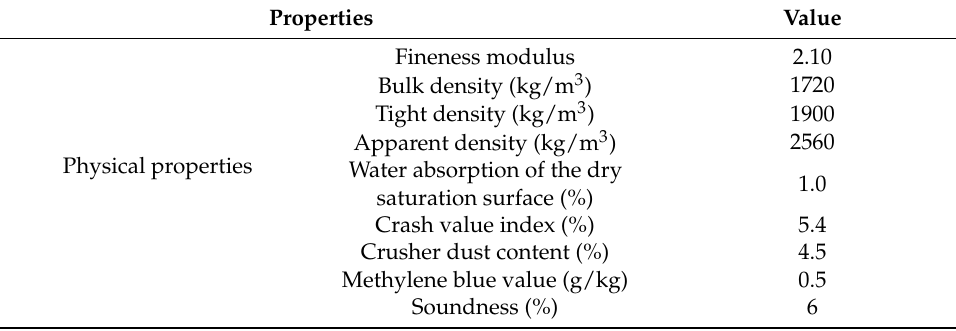
Table 4. Physical properties of manufactured sand.